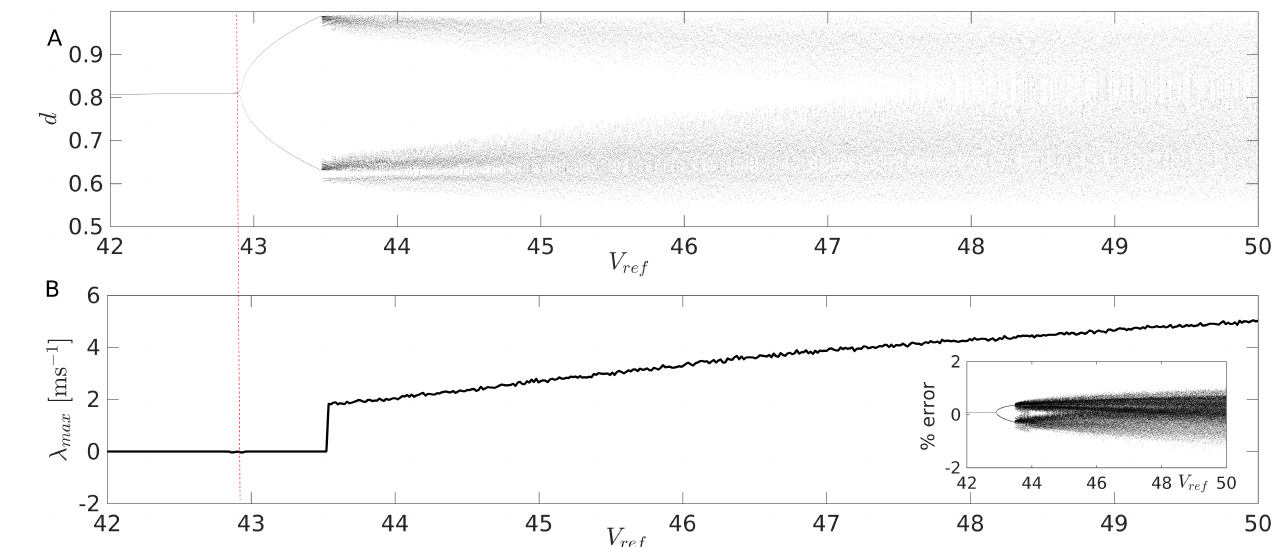
Figure 6. ( A ) Bifurcation diagram of the duty cycle; ( B ) maximal Lyapunov exponent near the disappearance of the Period 1 orbit in the interval V ref ∈ [ 42 V,50 V ] . Inset: Bifurcation diagram of the error. For each point in this diagram, a transient evolution of 2000 cycles is allowed before calculating the tangent evolution during 3000 cycles. Renormalization of the tangent vector is performed every 10